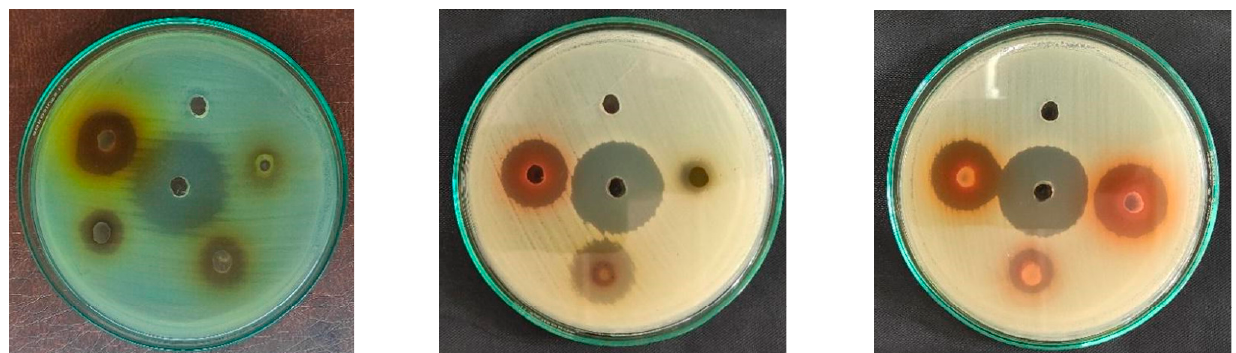
Figure 2. Antibacterial assays of plant extracts against Staphylococcus aureus ATCC 25923, Escherichia coli ATCC 25923, Salmonella typhi ATCC 14028, and Shigella sonnei ATCC 25931. Table 3. Zone of inhibition of different solvent fractions of plant extracts against B. ciliata , M. pudica , and P. emblica .